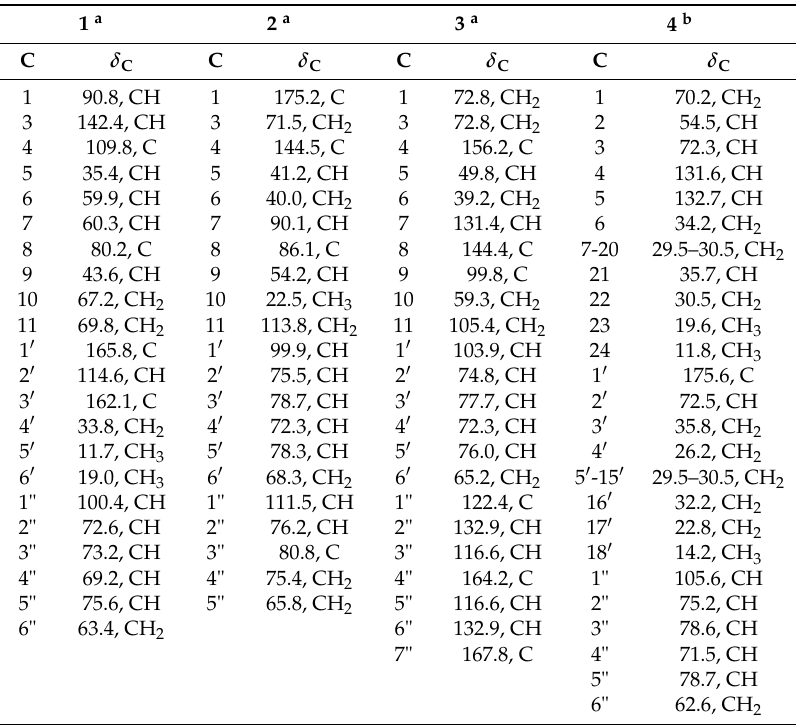
Table 2. 13 C-NMR data of compounds 1 – 4 (100 MHz, δ in